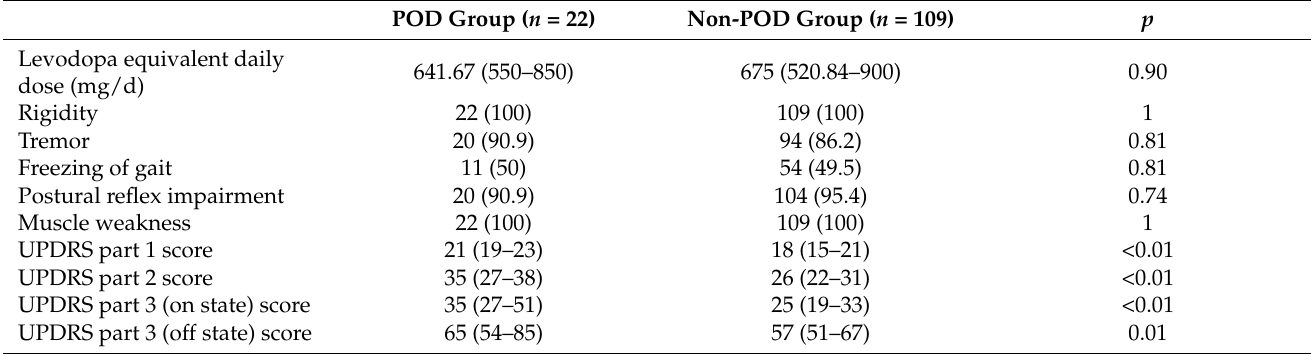
Table 2. Parkinson’s disease related motor and non-motor